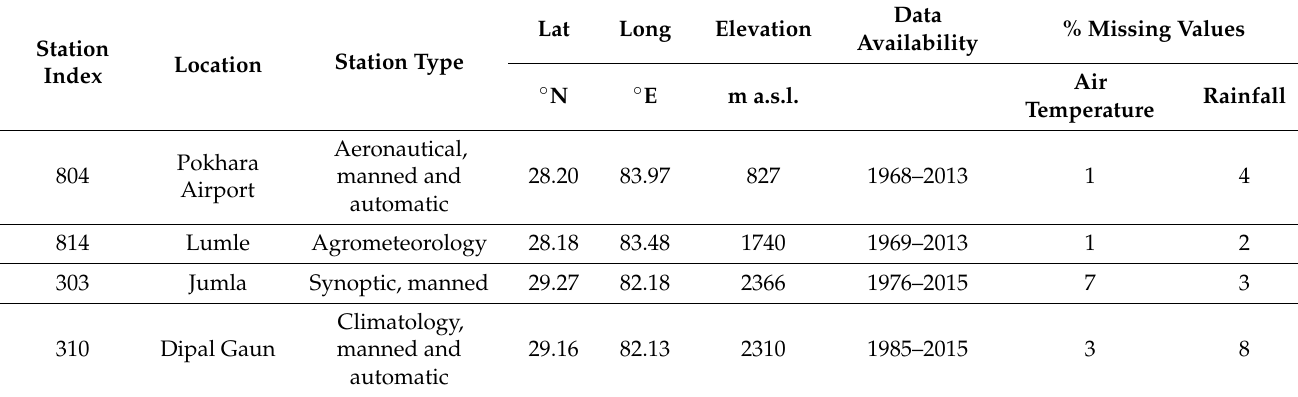
Table 1. Ground meteorological stations used from the Department of Hydrology and Meteorology, Nepal.